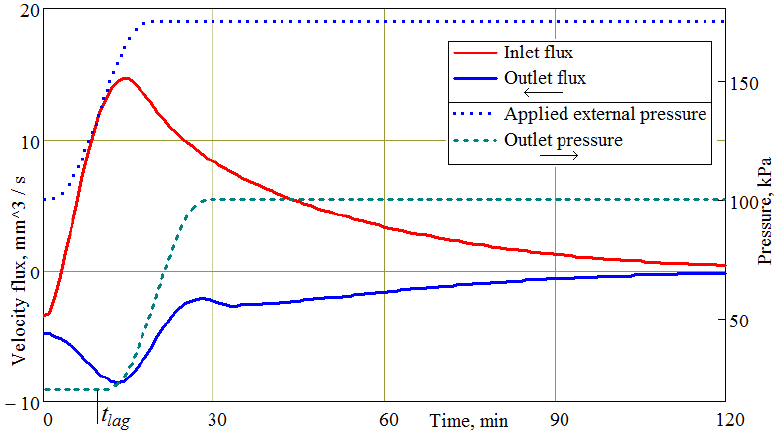
Figure 7. Combined time histories of fluid fluxes through the inlet and outlet since the beginning of the post-infusion stage and time dependencies in external compressive pressure and pressure in the vacuum vent.